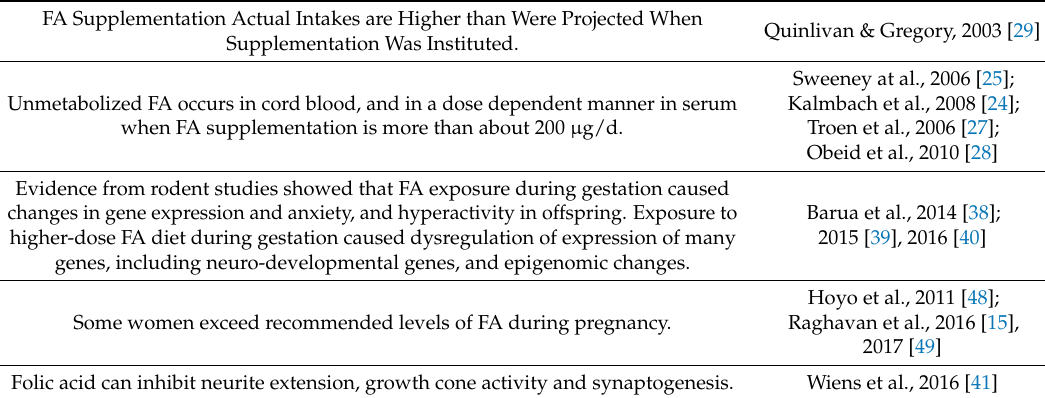
Table 1. Five important empirical findings related to Folic Acid